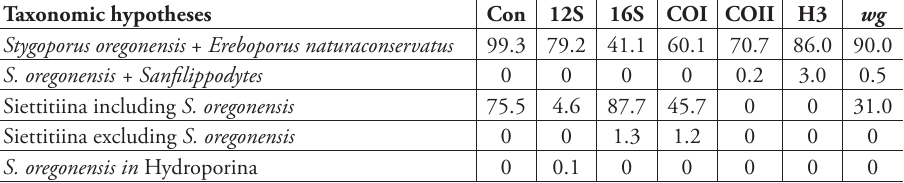
Figure 3. Maximum likelihood tree from concatenated dataset. Scale bar = 0.2 expected substitutions per position as estimated by RAxML. Stygoporus oregonensis in orange; other stygobitic dytiscids in blue; the epigean genus Sanfilippodytes , hypothesized by Larson and LaBonte (1994) to be the closest relative to S. oregonensis , in green. Bootstrap support given at nodes for Siettitiina and S. oregonensis + Ereboporus naturaconservatus . Table 2. Bootstrap support for placement of Stygoporus oregonensis . Taxonomic hypotheses are in the first column. Bootstrap support given as a percentage for each hypothesis for all analyzed matrices. “Con” refers to the analysis of the concatenated